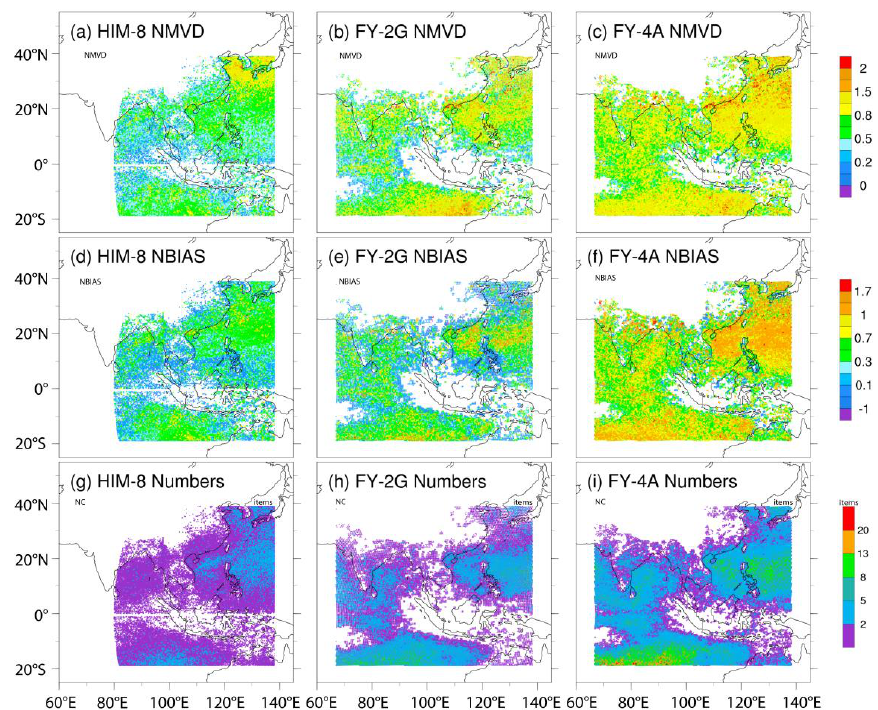
Figure 11. Same as Figure 10, but for low-level IR AMVs averaged.